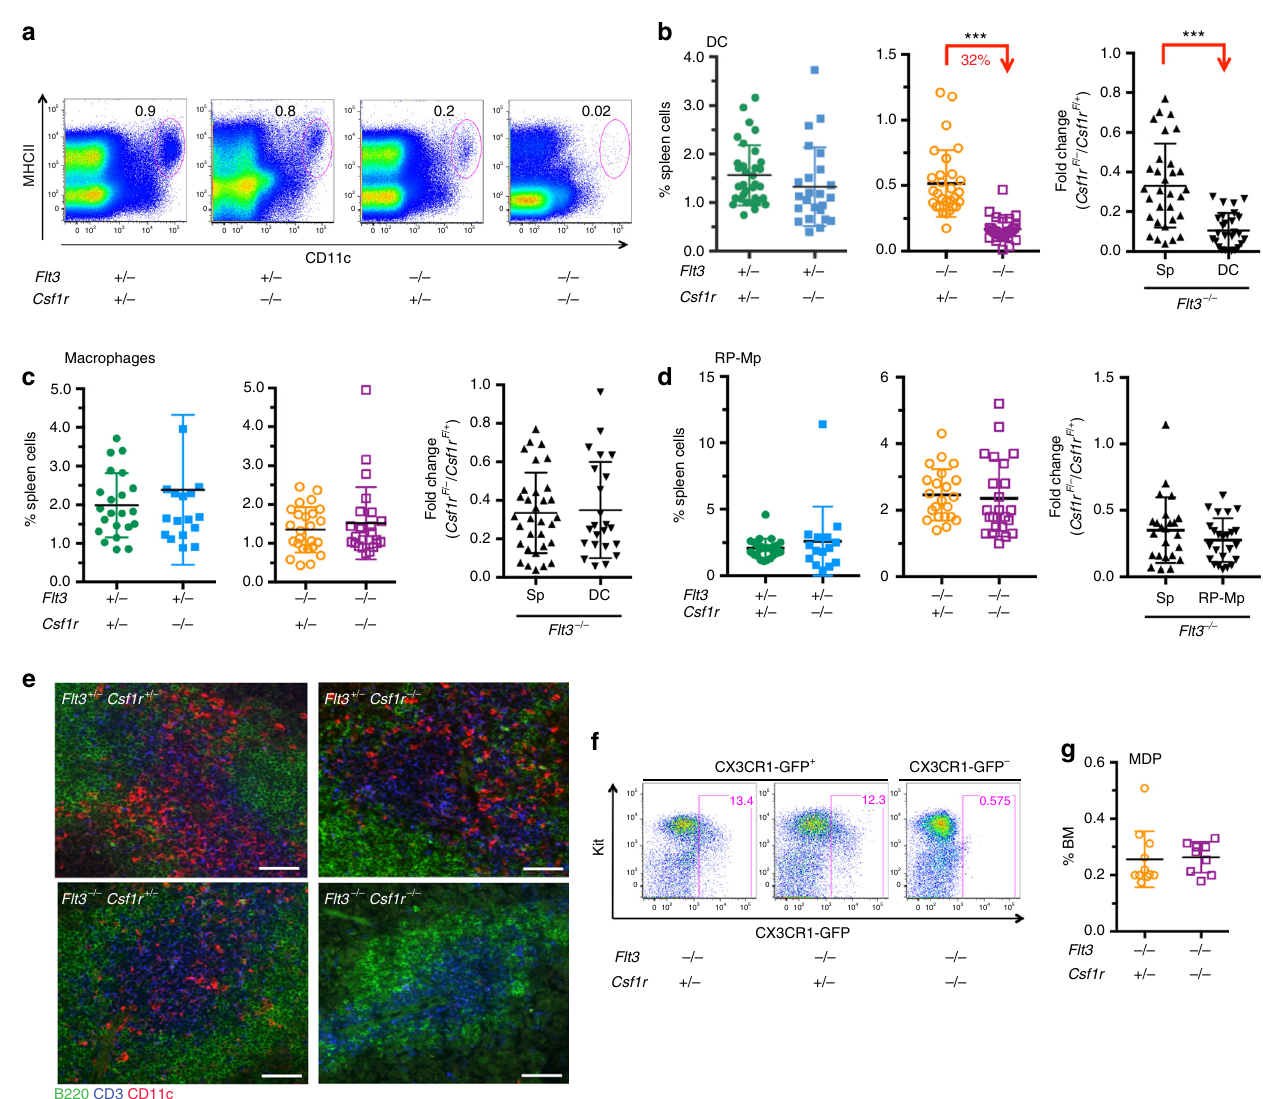
Fig. 1 Flt3 − / − ; Csf1r − / − mice lack spleen DCs. a Flow cytometry of spleen cells from wild-type, Flt3 − / − , Csf1r − / − , and Flt3 − / − ; Csf1r − / − mice. Numbers indicate frequencies of dendritic cells (DCs, CD11c hi MHCII hi ) within Dapi − cells. b Summary of DC frequencies (left, middle) in growth factor mutant mice. Right plot shows comparisons of fold changes between absolute leukocytes (CD45 + ) and DCs from the spleens of wild-type and receptor-de fi cient mice to normalize for overall changes in cellularity. Absolute cell numbers are shown in Supplementary Fig. 1b. Two-sided t test (left) and Mann – Whitney U test (right) were performed. SD is shown. c Frequencies and fold-change comparison of spleen macrophages (Gr-1 lo/ − CD11b + F4/80 lo SSC lo ) of wild-type and receptor-de fi cient mice as indicated. Gating is shown in Supplementary Fig. 1a. Two-sided t test (left) and Mann – Whitney U test (right) were performed. SD is shown. d Frequencies and fold-change comparison of spleen red-pulp macrophages (RP-Mps, Gr-1 lo/ − CD11b lo F4/80 hi SSC lo ) of wild-type and receptor-de fi cient mice as indicated. Two-sided t test (left) and Mann – Whitney U test (right) were performed. SD is shown. e Immunohistology of spleen sections of 3-week-old wild-type and receptor-de fi cient mice as indicated. Sections were stained using speci fi c antibodies recognizing B220 (green), CD3 (blue), and CD11c (red). ×20 objective was used for picture acquisition, scale bar corresponds to 50 μ m. Pictures are representative of three mice analyzed for each genotype. f Dot plots show the expression of CX3CR1-GFP in Lin − (Lin = CD3, CD19, TER119, NK1.1, CD11b, CD11c, B220, Gr-1) Sca-1 lo/ − bone marrow hematopoietic progenitor cells in Flt3 − / − ;Csfr1 + / − ;Cx3cr1-gfp + or Flt3 − / − ;Csf1r − / − ;Cx3cr1-gfp + mice. g Plot shows the quanti fi cation of macrophage dendritic cell progenitor (MDP) frequencies in the bone marrow as shown in f . Two-sided t tests was performed and SD is